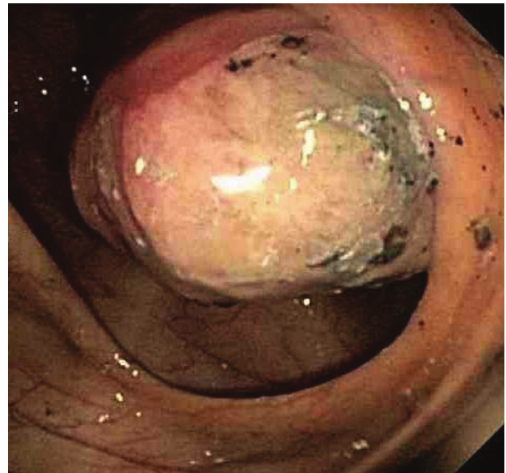
Figure 1: Superficially ulcerated cecal mass.